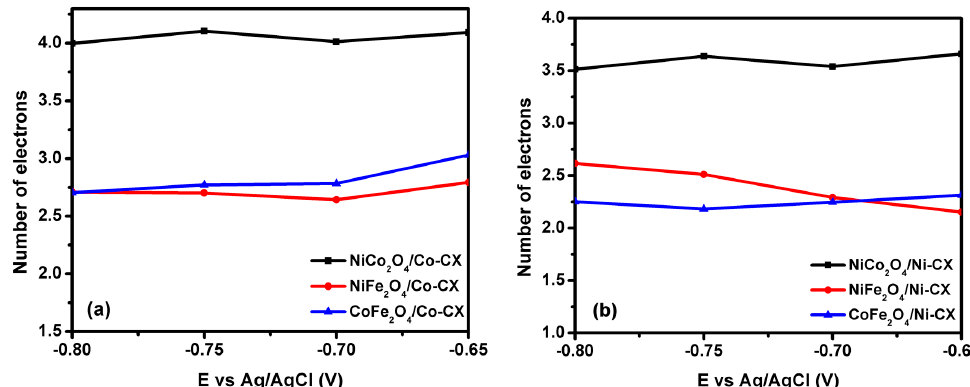
Figure 9. Variation of number of electron transferred with E vs. Ag/AgCl for bimetal oxides doped ( a ) Co-CX and ( b ) Ni-CX.